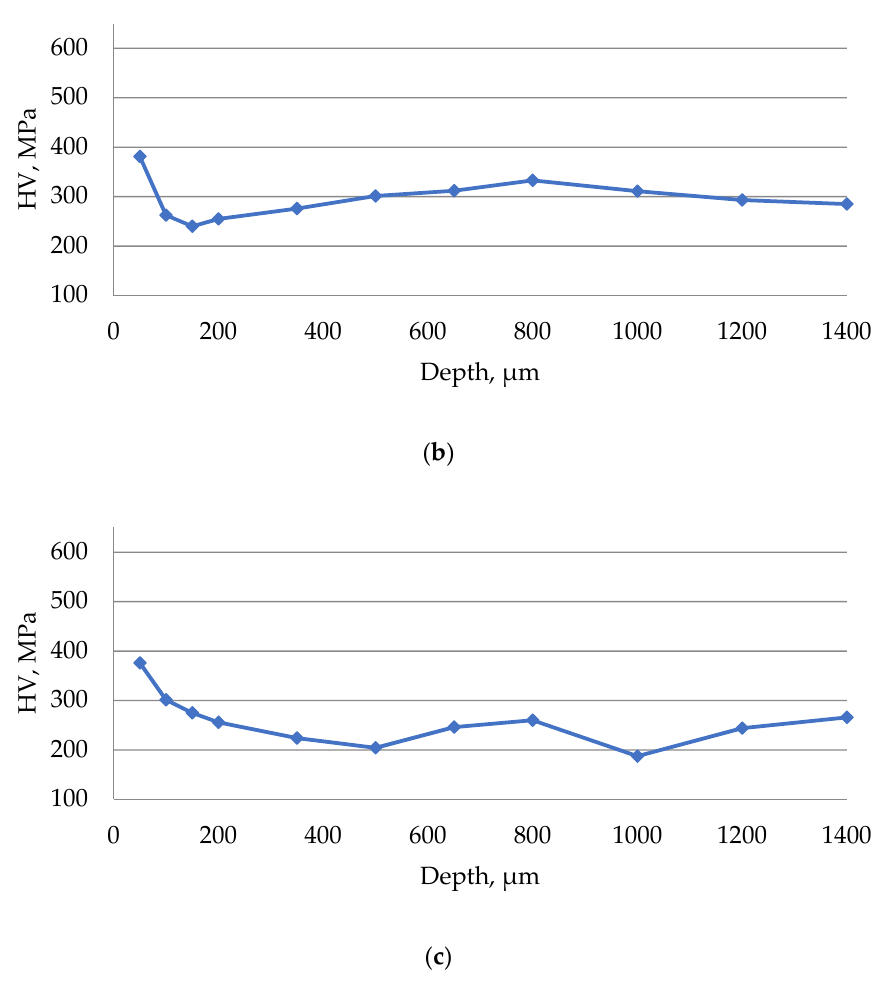
Figure 15. The results of measuring the microhardness of the surface of steel 15 after EDM in the rough mode using ETs from: ( a ) copper; ( b ) graphite; ( c ) composite.